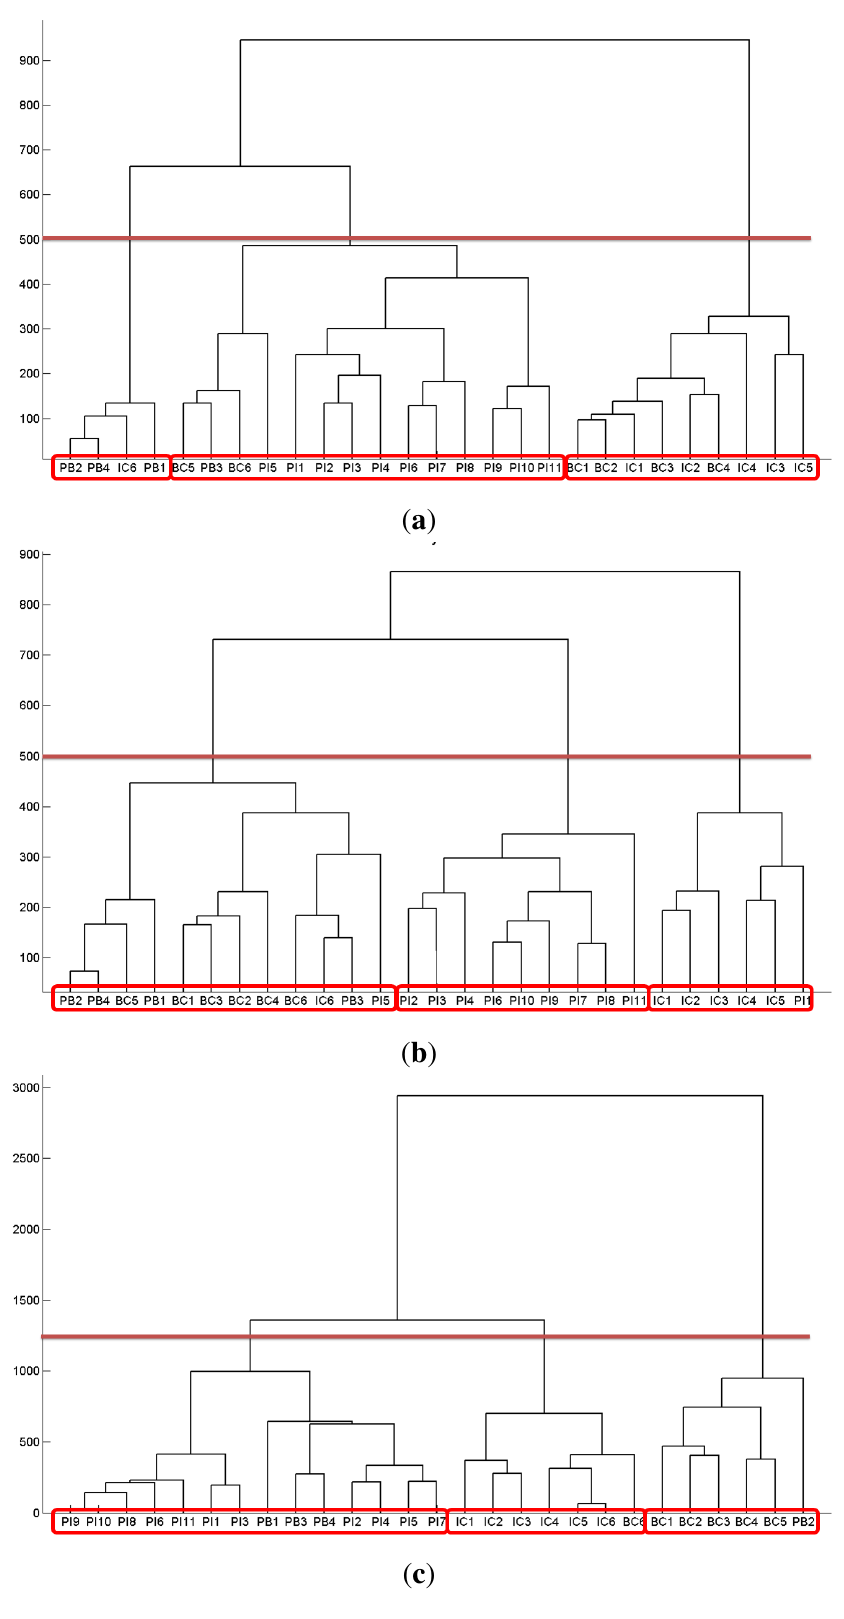
Figure 6. Dendrograms for network substitutability. Legend: PI x indicates the x -th pure insurer; PB y indicates the y -th pure bank; IC z the insurance component of the z -th financial conglomerate; and BC z the banking component of the z -th financial conglomerate. Source: ACPR data, authors’ calculation. ( a ) Volume (exposures in e ); ( b ) credit risk (exposures in % of owner’s equity); ( c ) funding risk (exposures in % of issuer’s